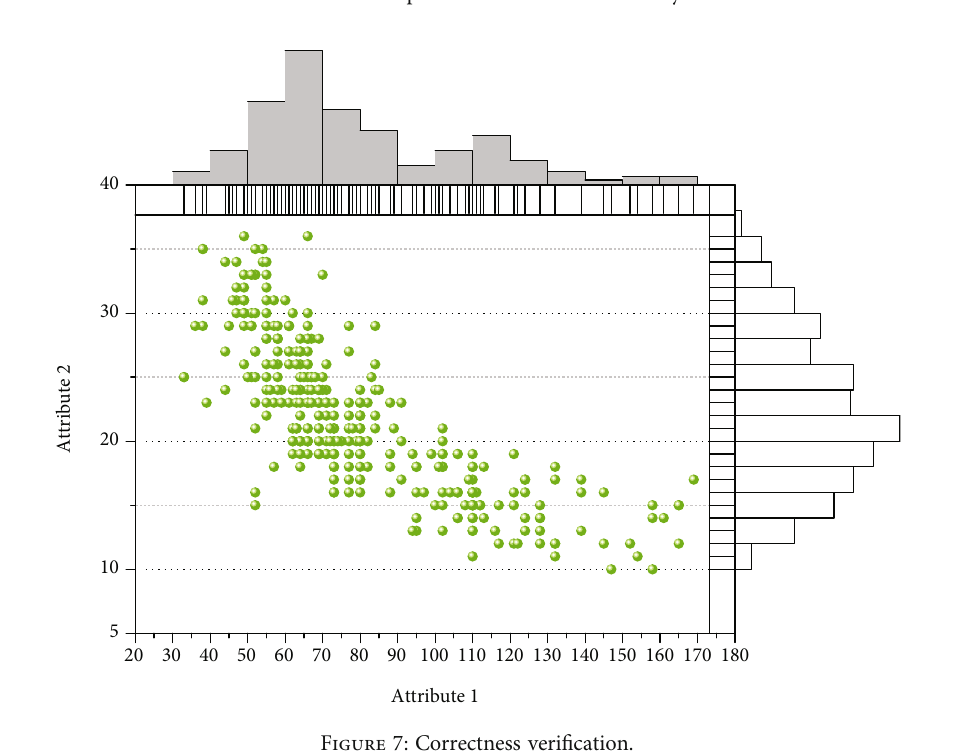
Figure 6: Comparison of information fi delity.